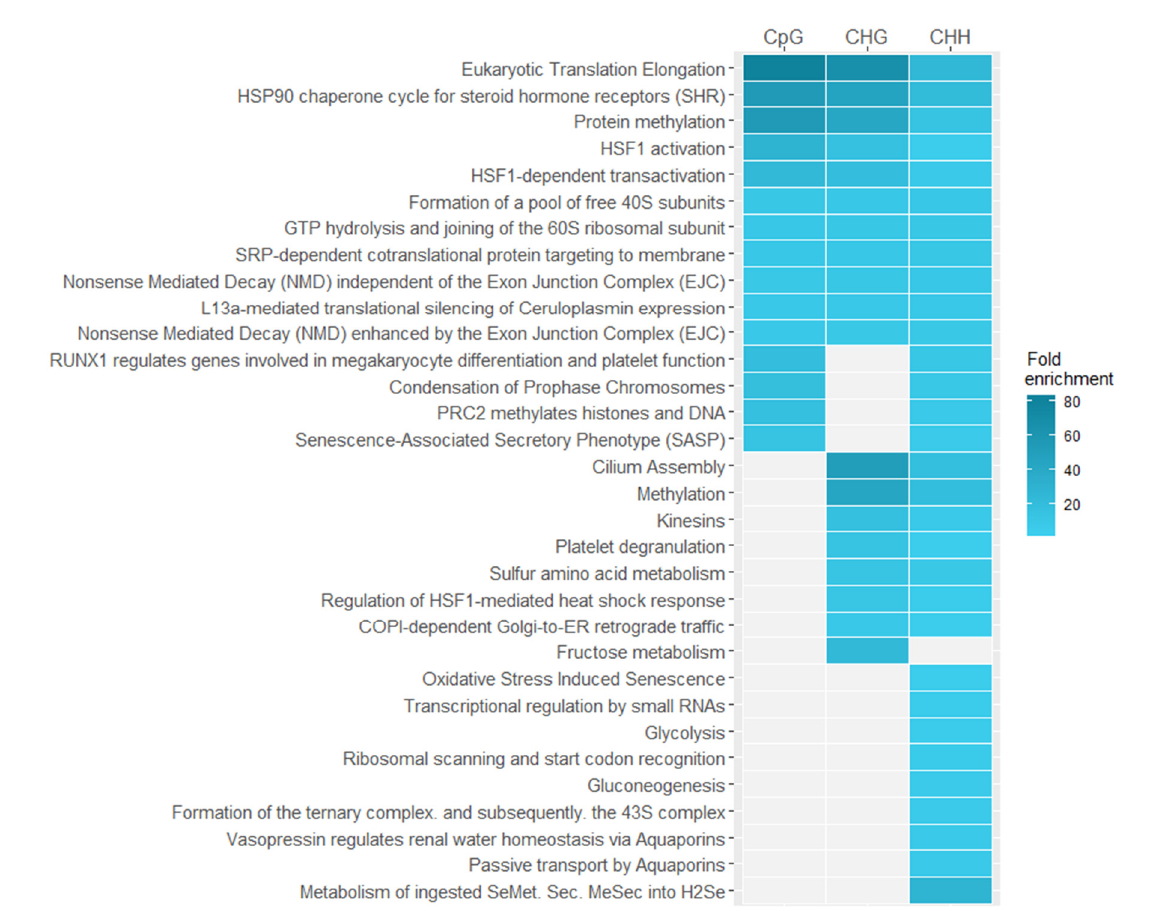
Figure 7. Pathways overrepresented in differentially methylated Arabidopsis thaliana genes in different sequence contexts (CpG, CHG, CHH).